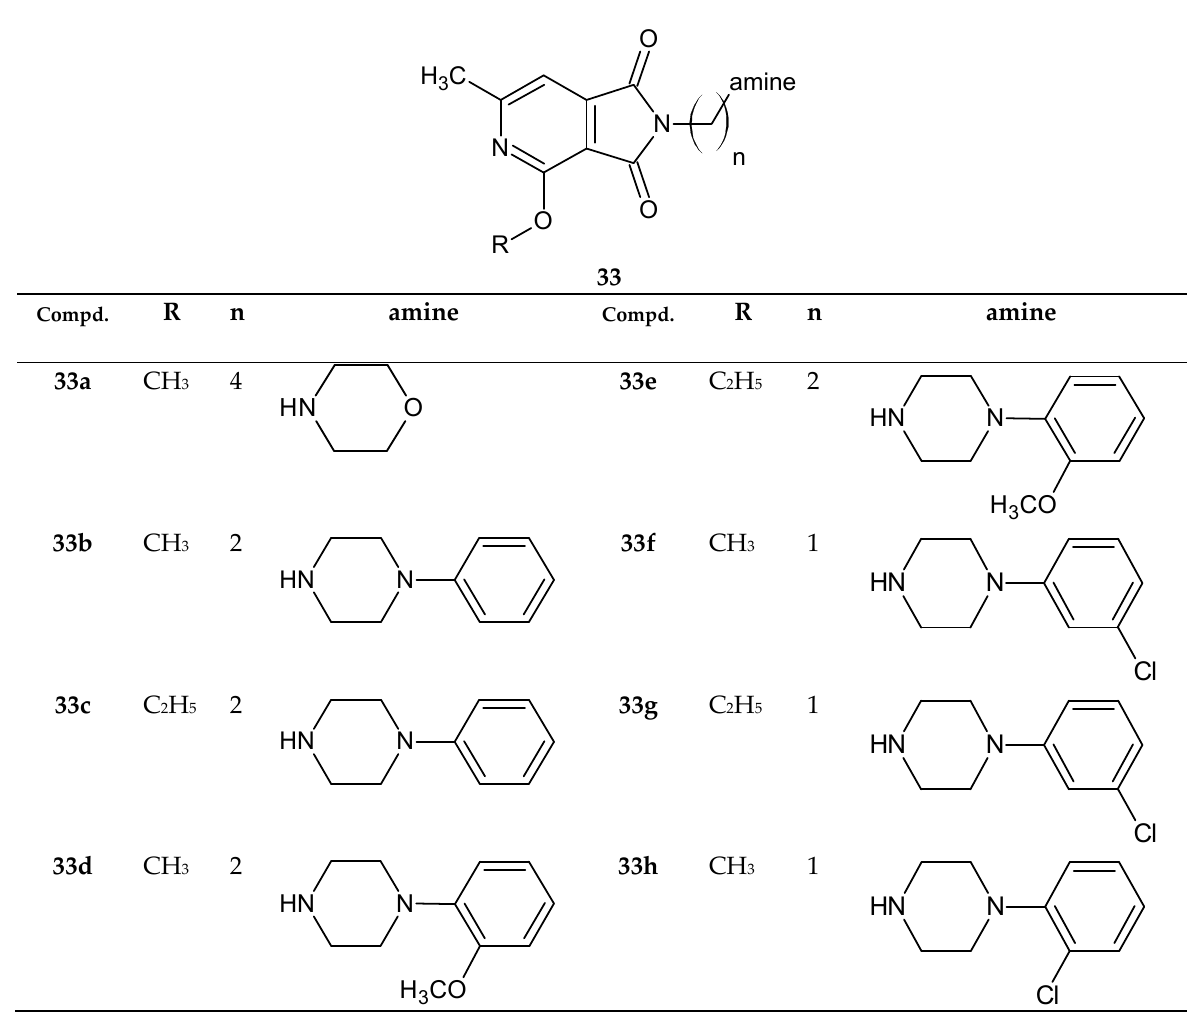
Figure 27. New derivatives of 1 H -pyrrolo[3,4- c ]pyridine-1,3(2 H )-dione 33a – 33h with a sedative activity (and an analgesic activity).